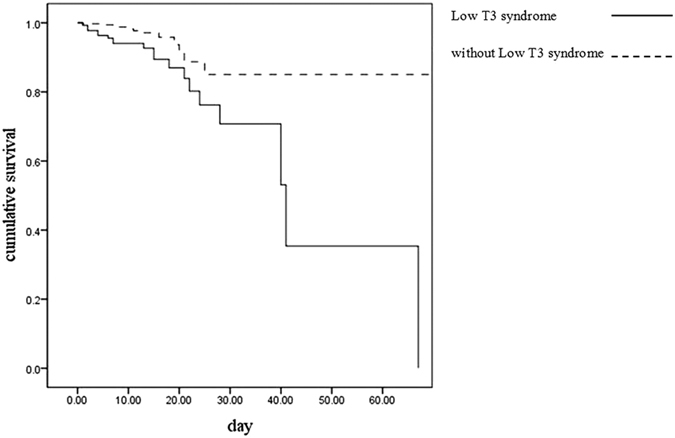
Survival analysis for patients with or without low T3 syndrome.